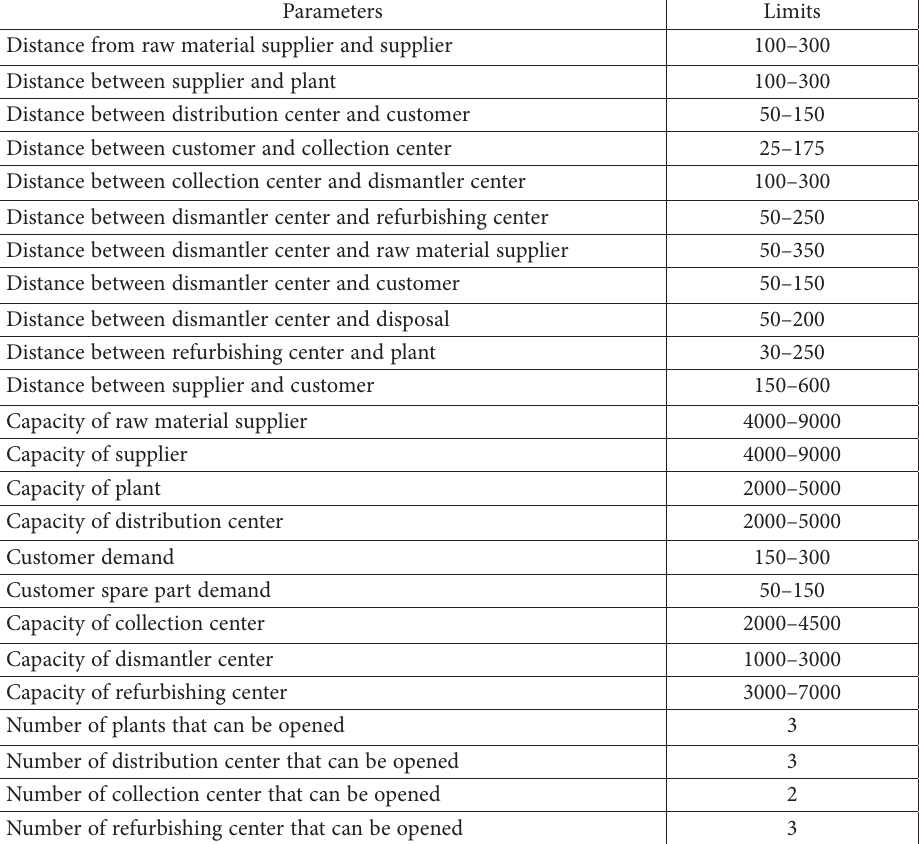
Table 1. The parameters used in illustrative